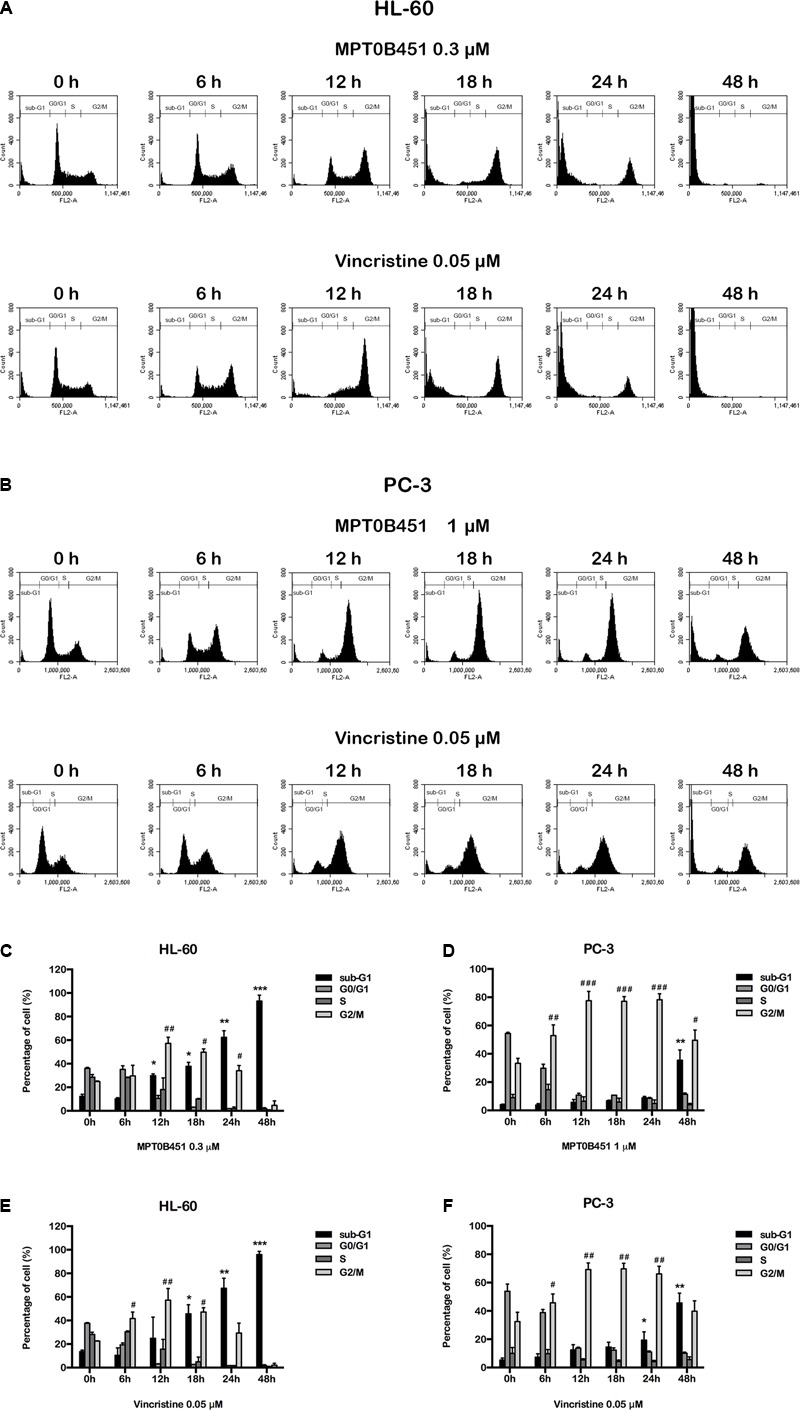
MPT0B451 induces mitotic arrest in HL-60 and PC-3 cells. The histograms of cell cycle distribution were detected by flow cytometry. (A) HL-60 cells were treated with MPT0B451 (0.3 μM), and (B) PC-3 cells were cultured in 1 μM MPT0B451 for 6, 12, 18, 24, and 48 h. (C–F) The statistical analysis of cell cycle distribution. (C,E) HL-60 cells were treated with MPT0B451 or vincristine, and (D,F) PC-3 cells were treated with MPT0B451 or vincristine for 6, 12, 18, 24, and 48 h. The data were repeated at least three independent experiments. ∗p < 0.05, ∗∗p < 0.01, and ∗∗∗p < 0.001, compared with sub-G1 0 h untreated group; #p < 0.05, ##p < 0.01, and ###p < 0.001 compared with G2/M 0 h untreated group.